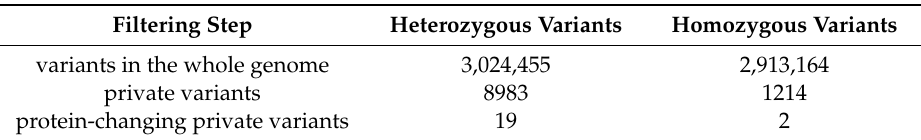
Table 2. Results of variant